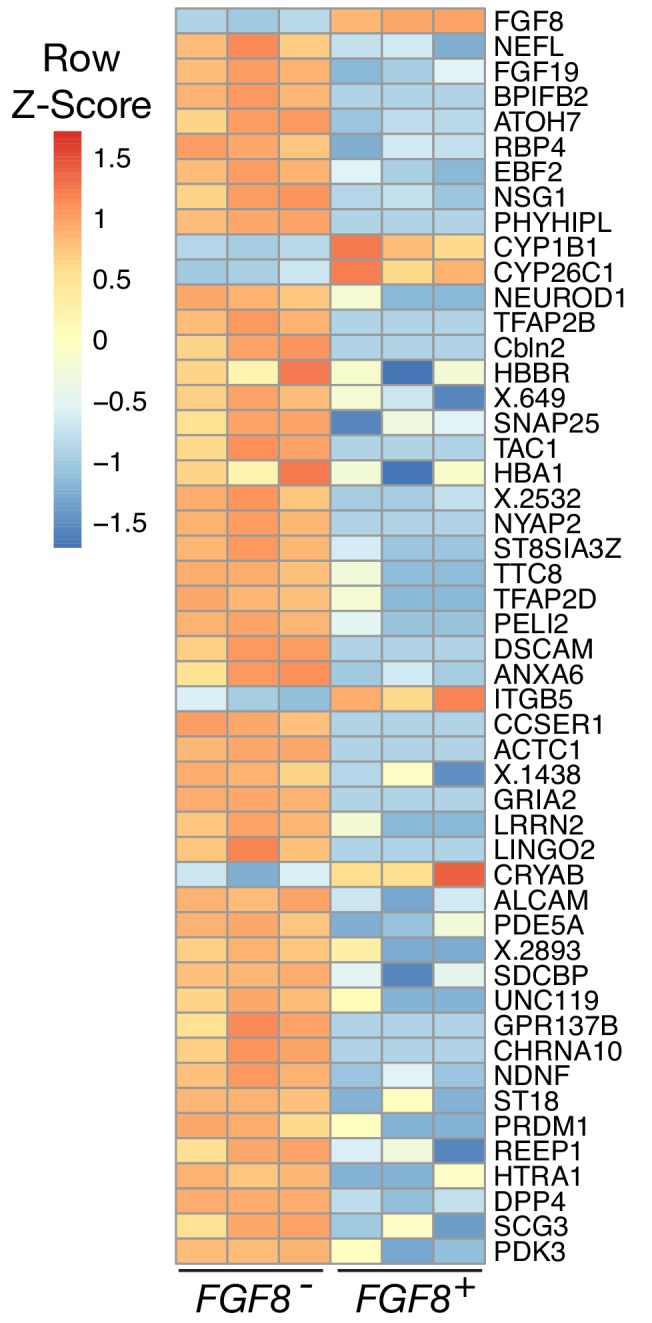
Early differentiation markers are enriched in the FGF8- population.A heatmap of top 50 unbiased differentially expressed genes between FGF8+ and FGF8- populations in the developing chick retina.